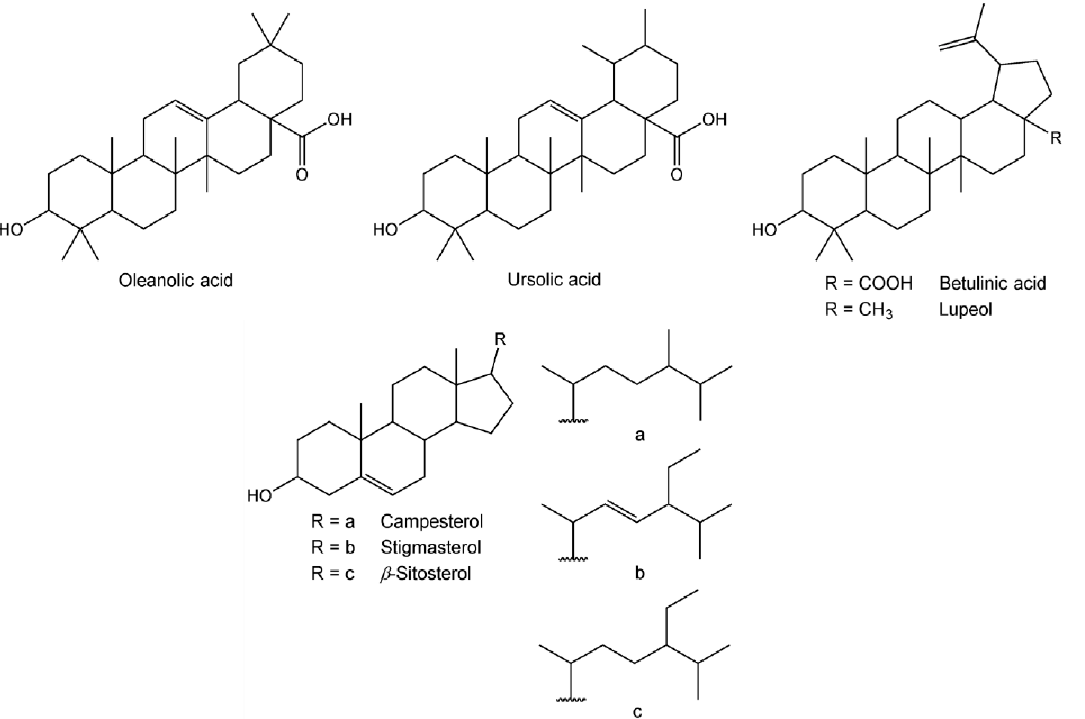
Figure 3. Structures of pentacyclic triterpenic compounds and sterols identified in Z. lotus.